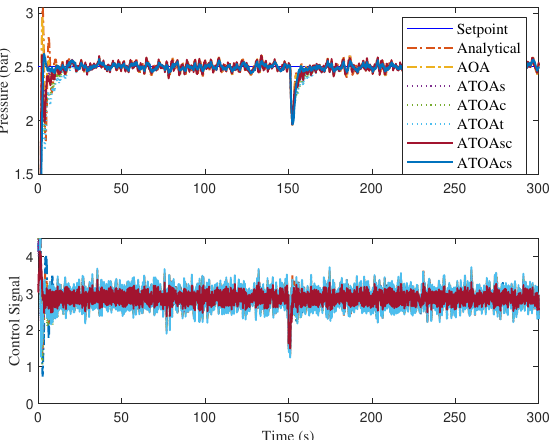
Figure 8. Disturbance rejection and set-point tracking performance of the FOPPI